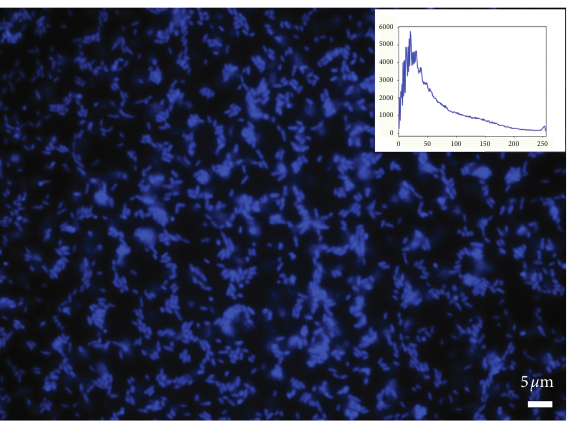
Figure 6: Cultures of S. Braenderup on the LB medium without AgNPs and stained with DAPI (control).